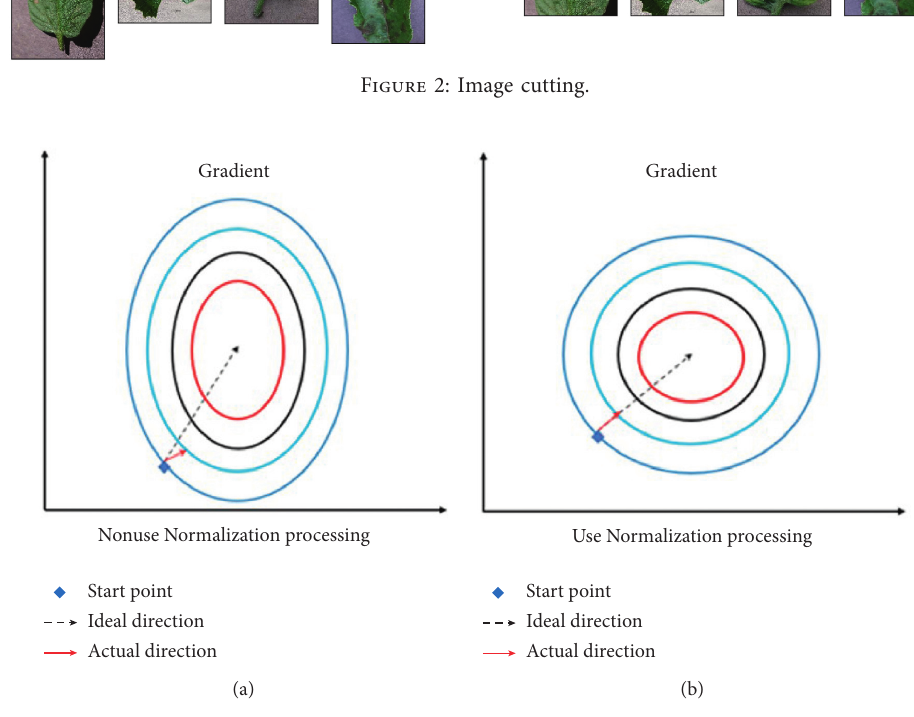
Figure 3: The effect of data normalization on gradients.